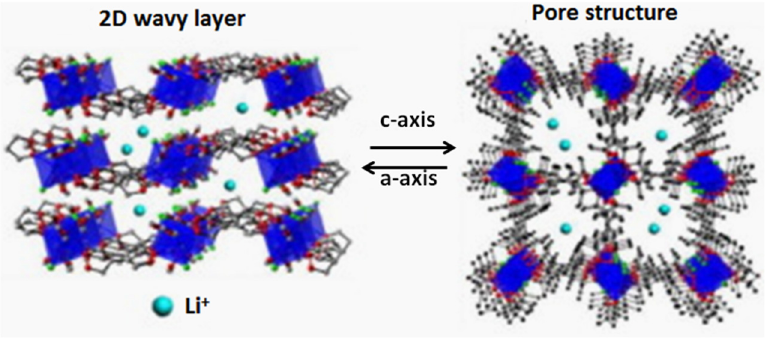
Figure 13. 2D layered nickel-based MOF (C 20 H 24 Cl 2 N 8 Ni) [69]. Reproduced with permission.